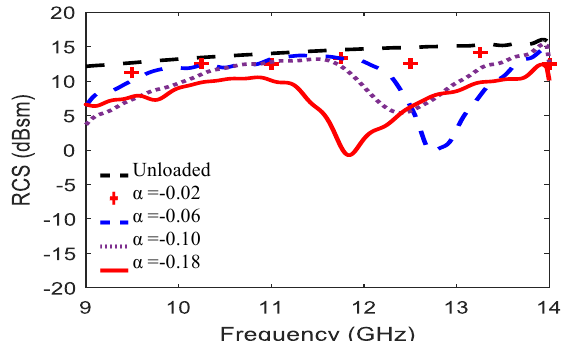
Fig. 3. The RCS versus frequency in one direction tapered holes at